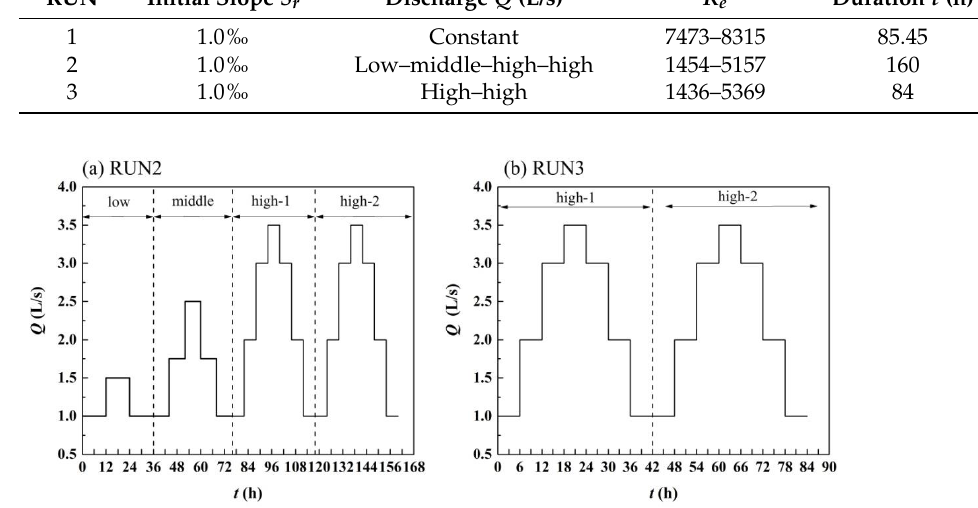
Figure 3. Variable discharges in ( a ) RUN2 and ( b )